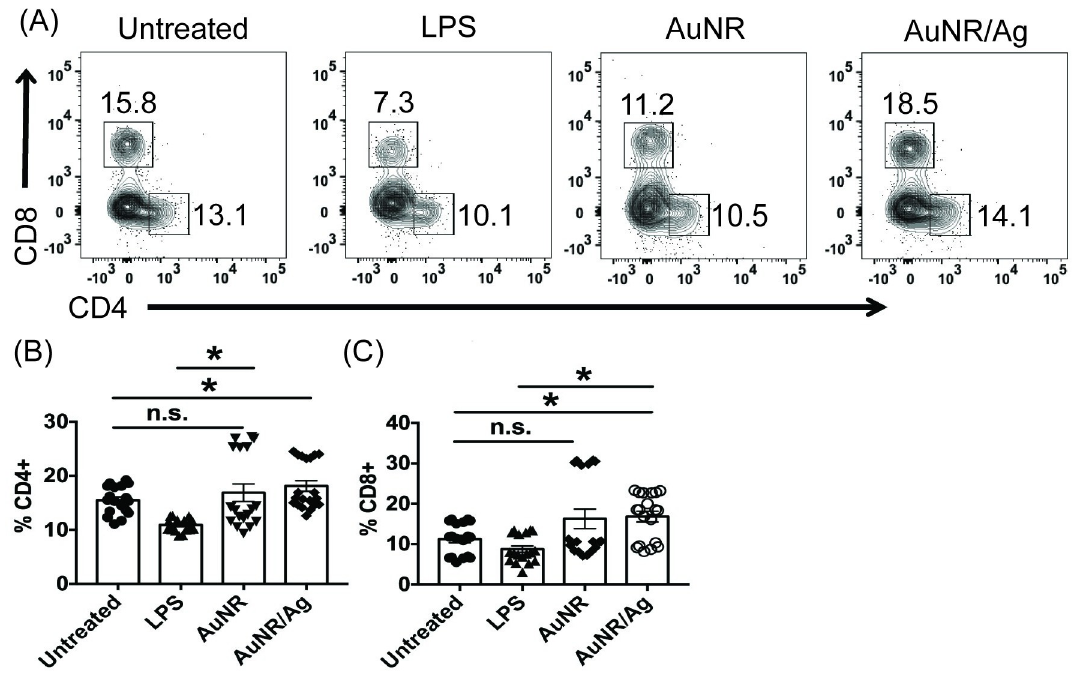
Fig 2. AuNR and AuNR/Ag have different impacts on CD4+ and CD8+ T cells. Splenocytes were treated with 5 μ g/ml of LPS or 100 μ g of either AuNR or AuNR/Ag for 72 hours, and flow cytometry was performed. The flow data are gated on the percent live, and the combined data represent 3 independent experiments with at least 3 technical replicates. The data is represented as scatter dot plots, where error bars represent the standard error of the mean; � p � 0.05 is significant as determined by a two-sided t test.